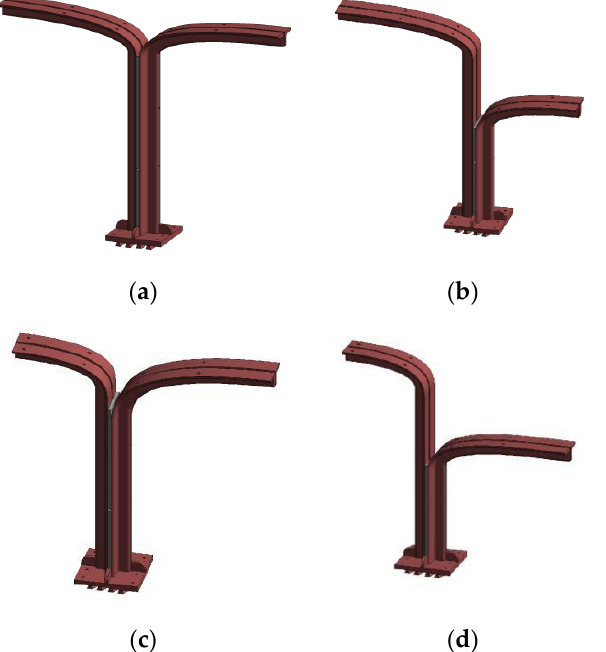
Figure 10. Parameterised units of different configurations. ( a ) Standard unit; ( b ) Unit with the same span but different heights; ( c ) Unit with the same height but different spans; ( d ) Unit with different heights and spans.